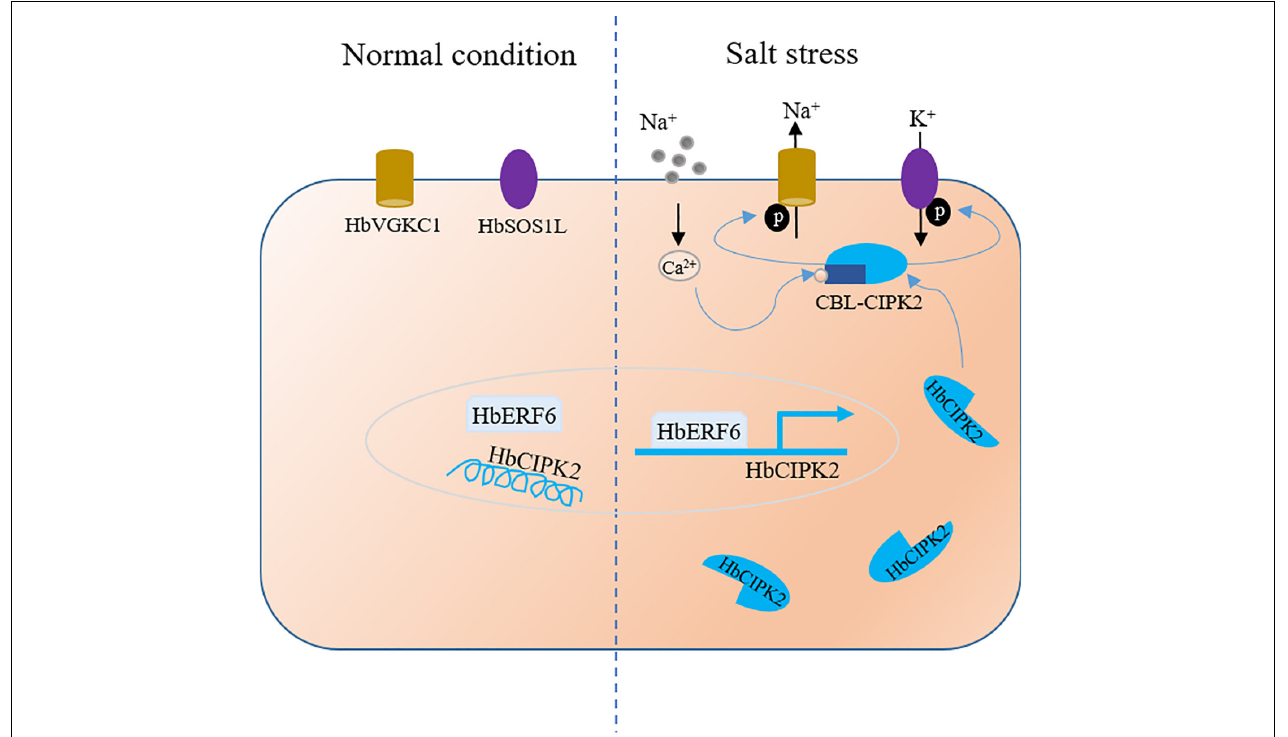
FIGURE 7 | The working model for HbERF6 regulating HbCIPK2-mediated pathways under salt stress. The expression of HbERF6 is induced by salt conditions. HbERF6 acts as a transcription factor, binds to the promoter of HbCIPK2 , and activates the transcription of HbCIPK2 under salt stress. Then, HbCIPK2 can phosphorylate K + channel HbVGKC1 and Na + transporter HbSOS1L to coordinate K + /Na +